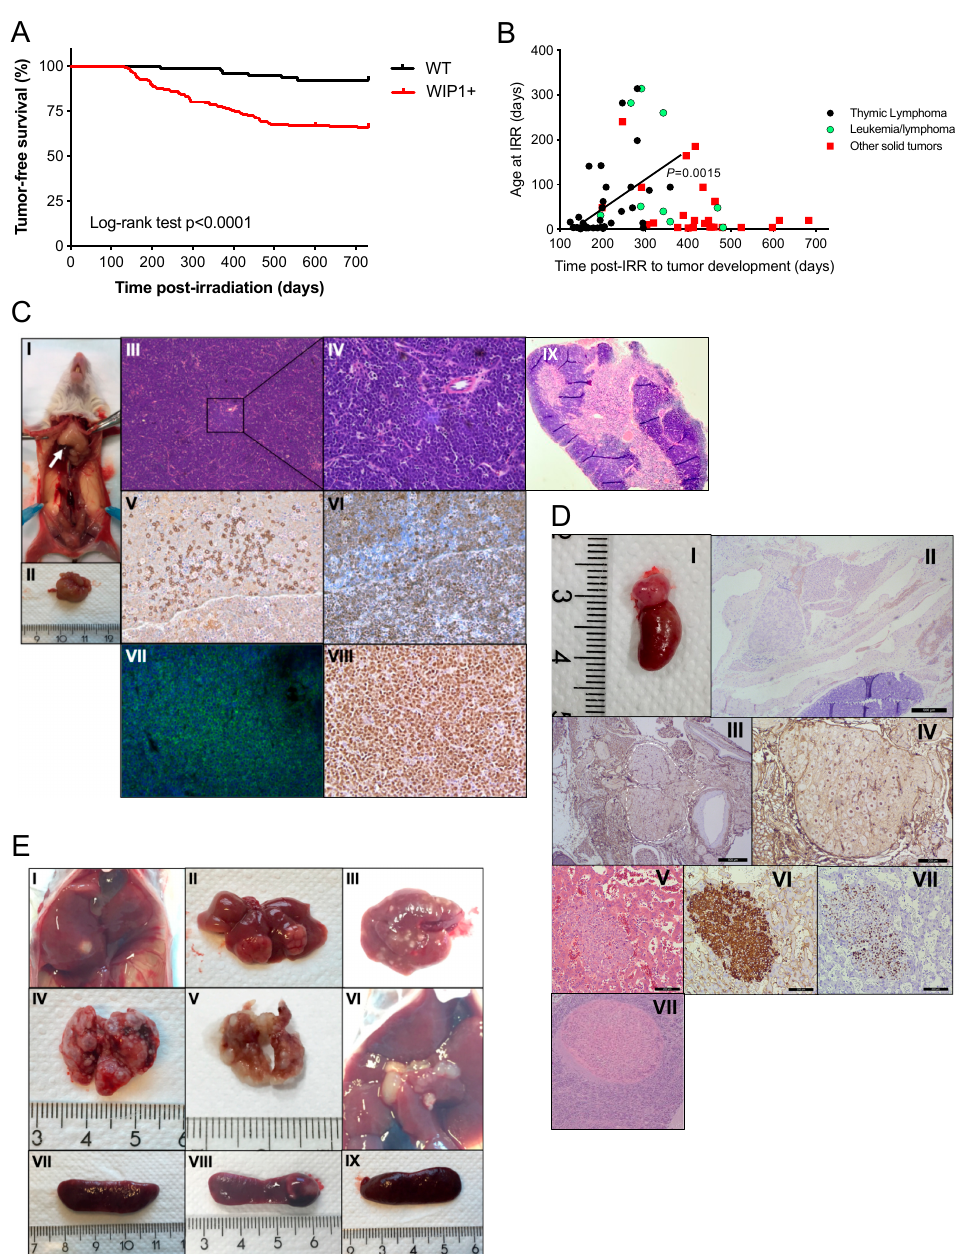
(Figure 2E and Table 1). The odds ratio of developing cancer in mice with the PPM1D transgene was 6.3 (95% confidence interval 2.7–14.2) compared to wild-type mice.